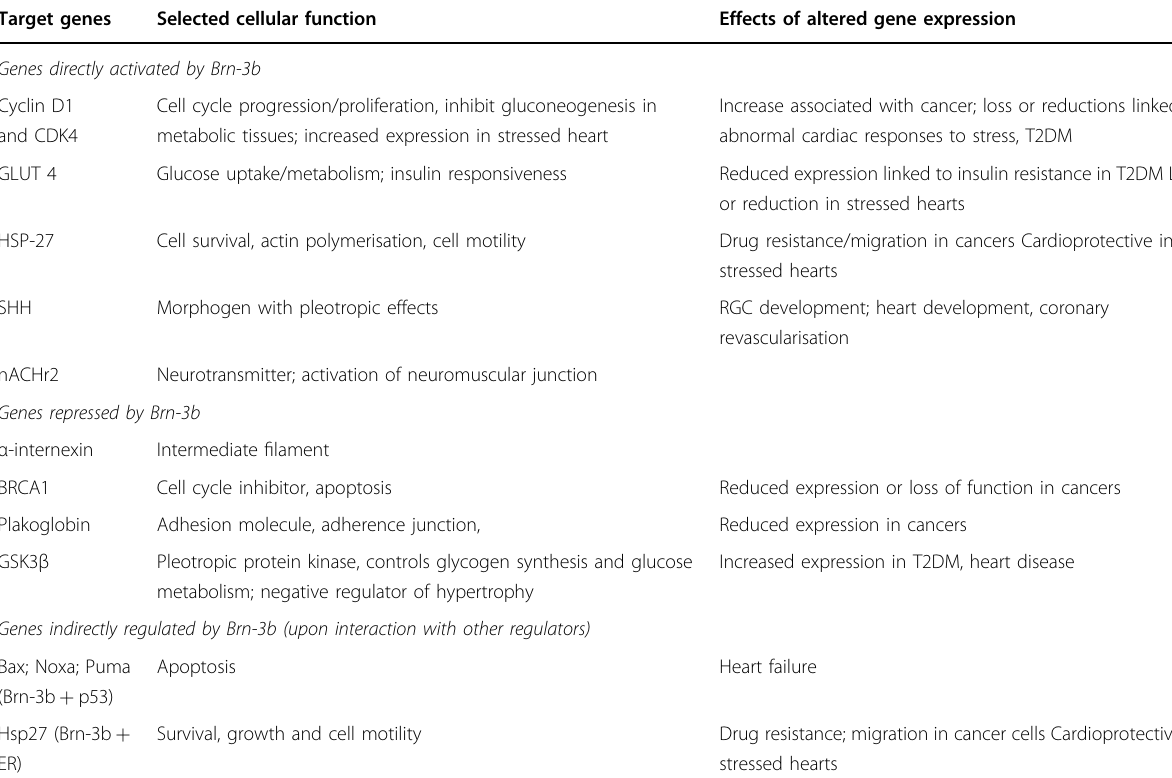
Table 2 List of known Brn-3b target genes with selected cellular functions and potential effects of changes on clinical